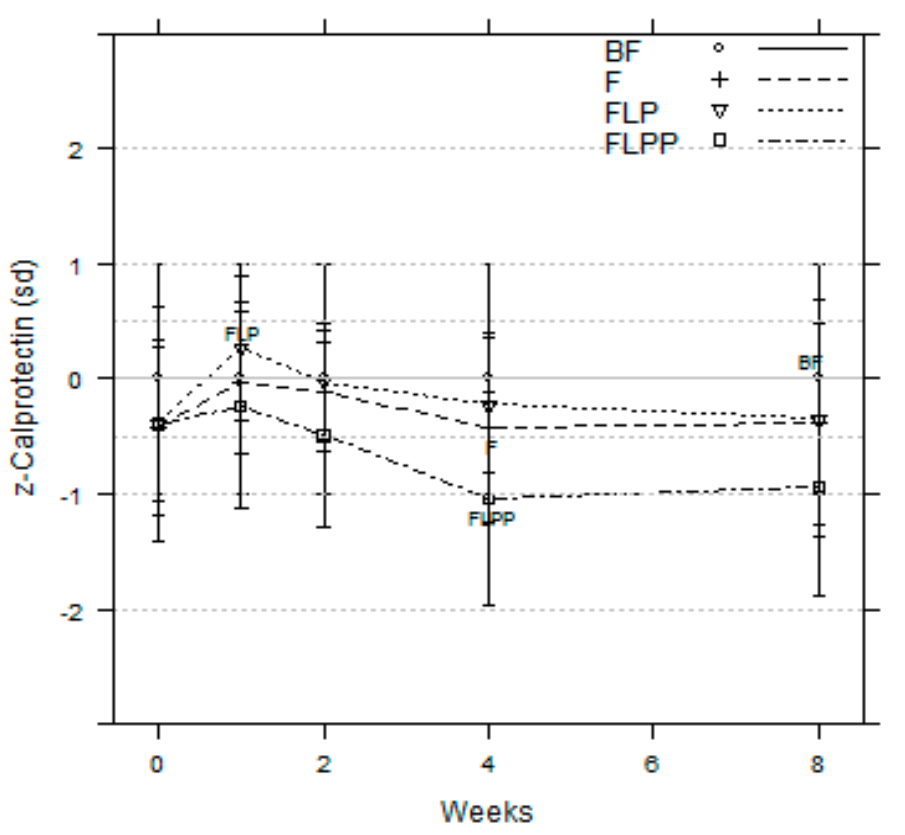
Figure 2. Fecal calprotectin z-scores compared to breastfed group set as zero line (PP